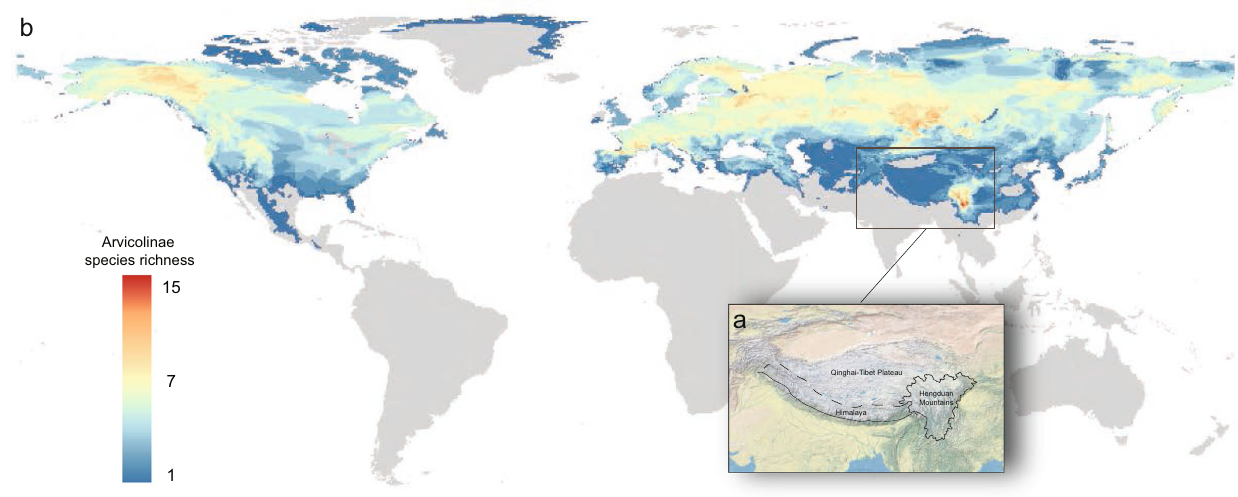
Fig. 1 a Geographic location of the Hengduan Mountains. b Global species richness map of Arvicolinae. Grid cells (50 × 50 km) in red show the highest richness, whereas blue indicates the lowest richness. The distribution data of global Arvicolinae species were obtained from the literature 21 , online databases (IUCN red list of threatened species) and our fi eld work